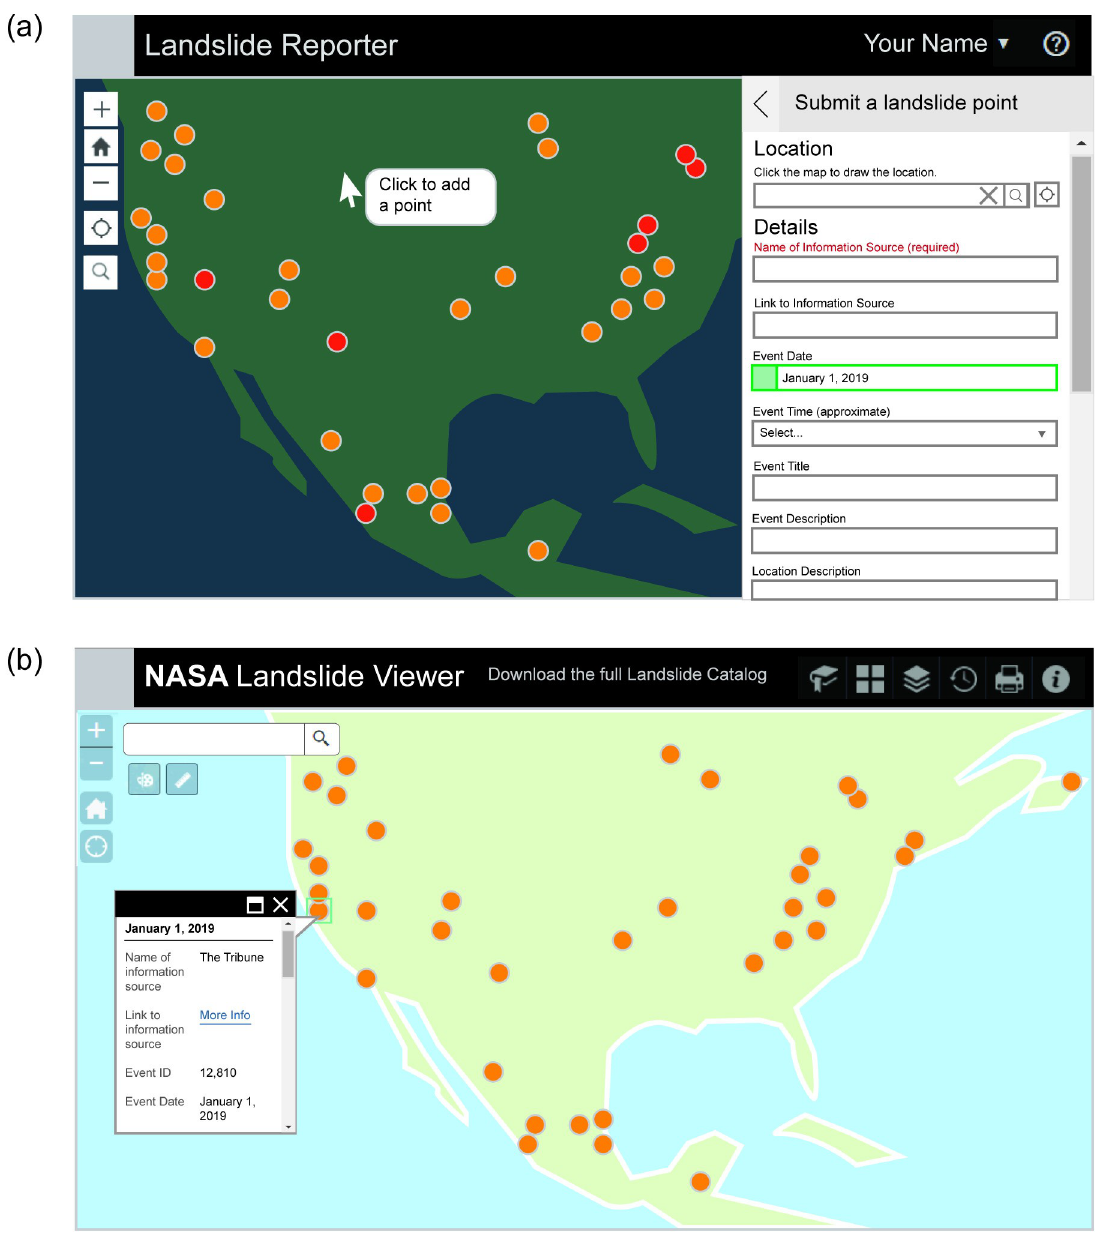
Fig 2. Web application components of the Cooperative Open Online Landslide Repository (COOLR). The figures outline the general design of the web applications for Landslide Reporter and Landslide Viewer: (a) illustration of Landslide Reporter showing the form to report a new landslide, and (b) illustration of Landslide Viewer with the Landslide Points layer